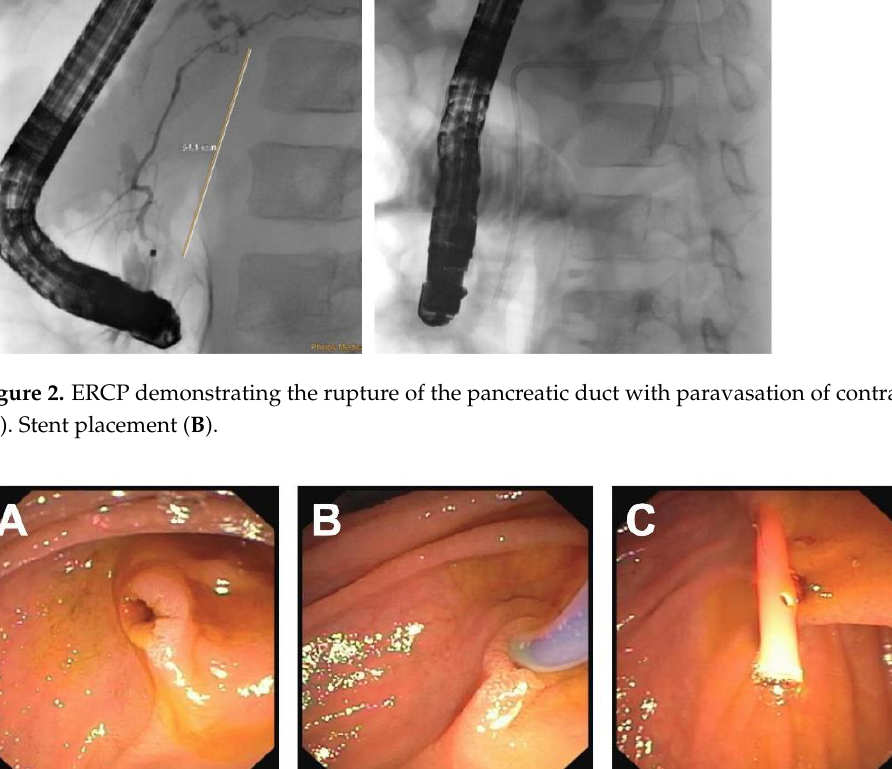
Figure 3. Major duodenal papilla leaking bile ( A ). Application of contrast dye into the principal pancreatic duct ( B ). Stent with multiple perforation in place ( C ).